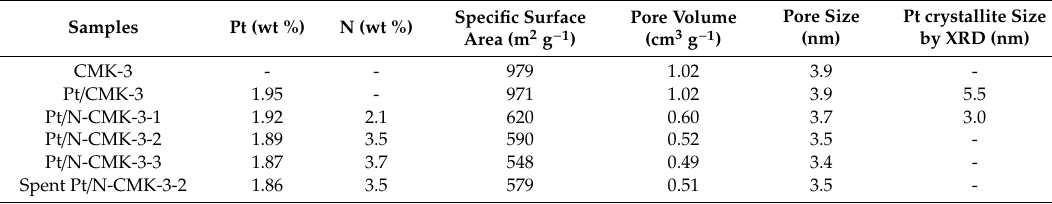
Table 1. Pt and N contents, and physical properties of prepared